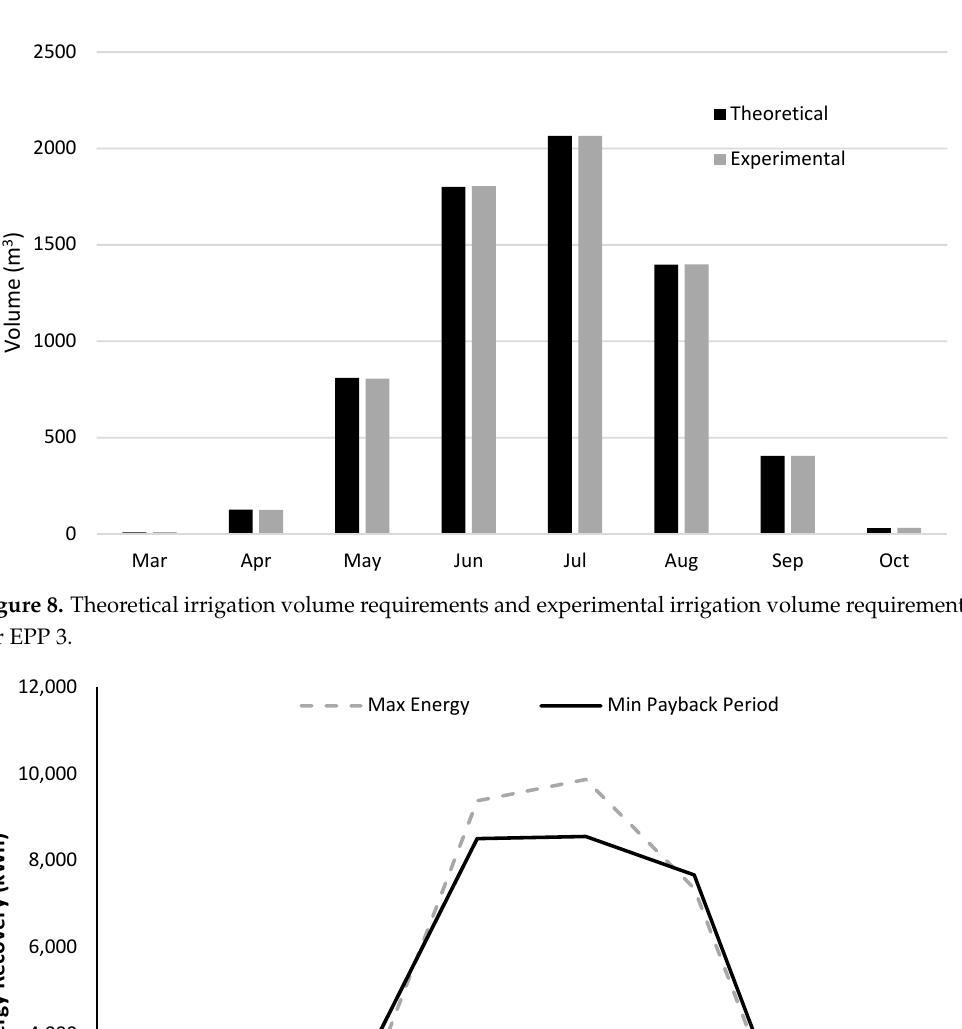
Figure 7. Experimental flow distribution during the irrigation season for EPP 3.